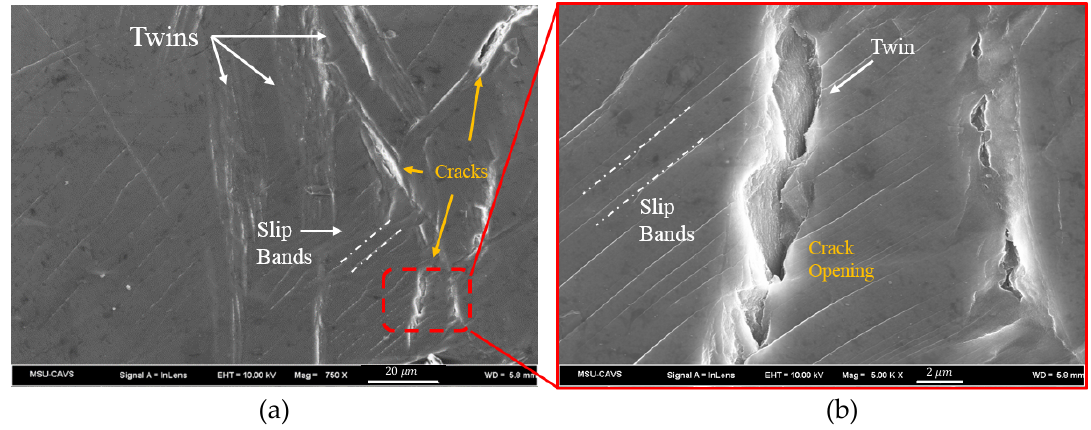
Figure 7. ( a ) Micrographs depicting slip–twin interactions induced crack nucleation and ( b ) zoomed image showing crack opening due to slip-twin interactions from the dashed red region in ( a ).